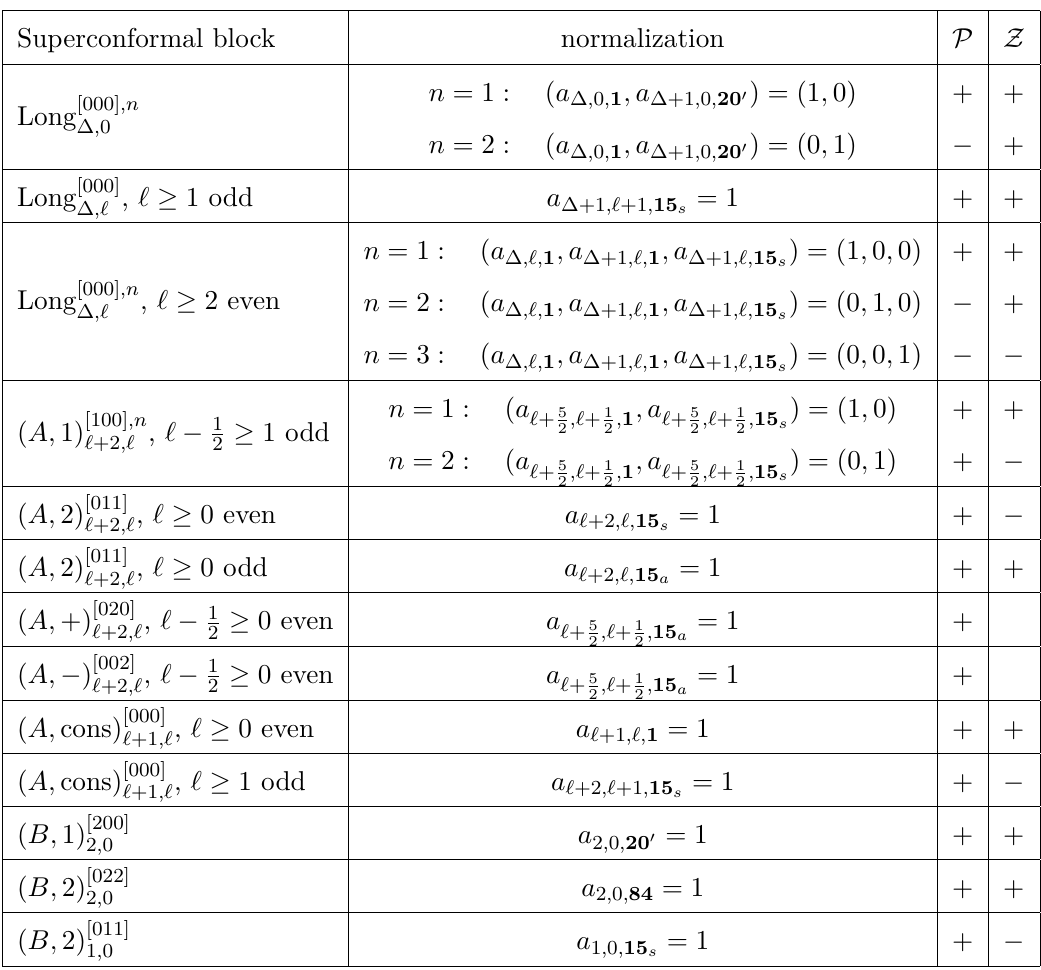
Table 5 . A summary of the superconformal blocks and their normalizations in terms of a few OPE coefficients. The values a ∆ ,‘, r in this table correspond to a I in eq. (2.51) — we omitted the ∆ ,‘, r index I for clarity. Note that the ( A, ± ) are complex conjugates and do not by themselves have well defined Z parity, but together they can be combined into a Z -even and a Z -odd